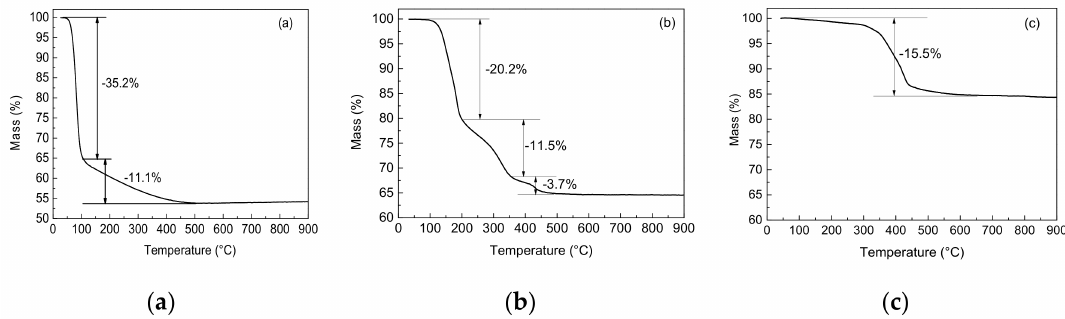
Figure 2. TGA curves of ( a ) sodium tetraborate decahydrate, ( b ) ammonium pentaborate, and ( c ) zinc borate. Table 2. Thermogravimetric analysis of NaB, NHB, and ZB fillers.